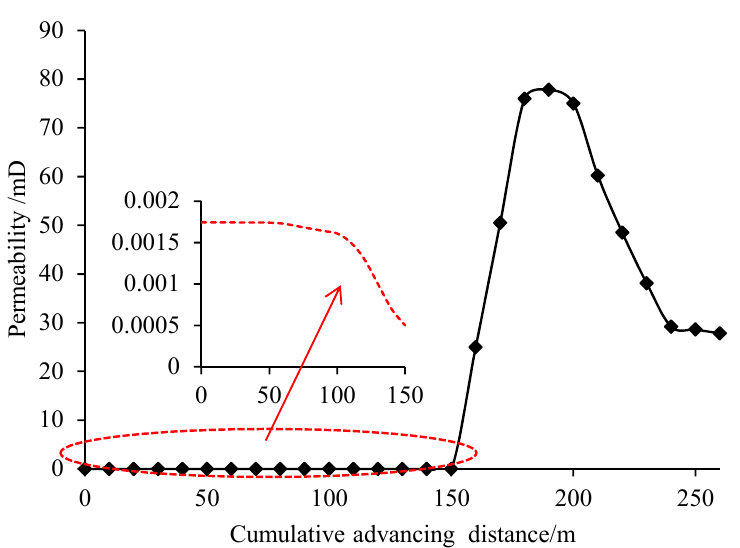
Figure 8. Gas permeability evolution curves of the protected coal seam from the start-line (0 m) to 260 m.